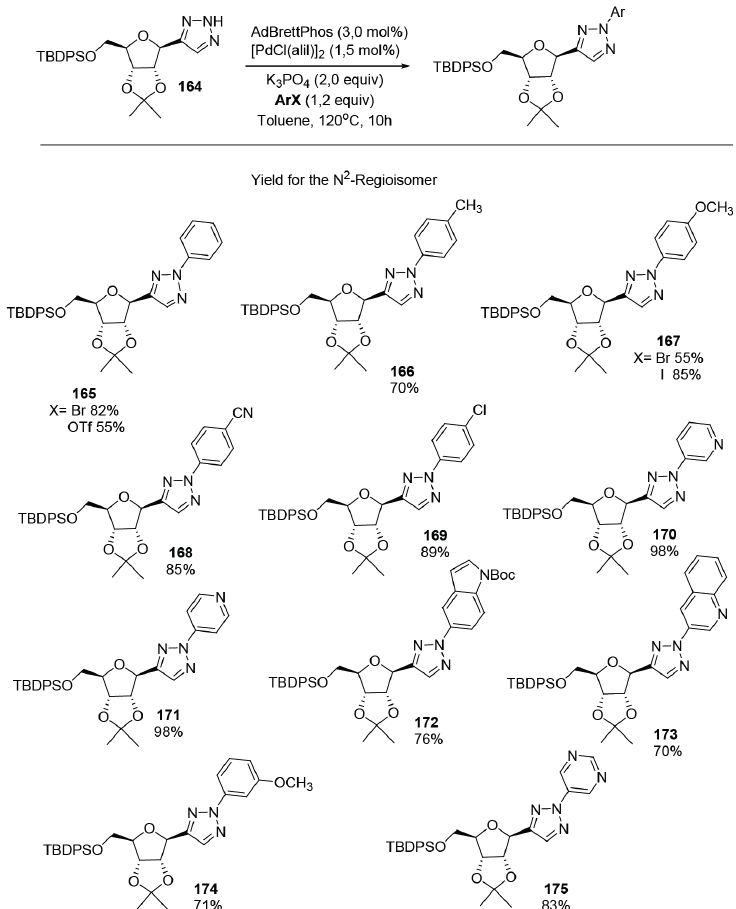
Figure 23 - The Palladium catalyzed N 2 -Regioselective Arylation of β -Triazoyl